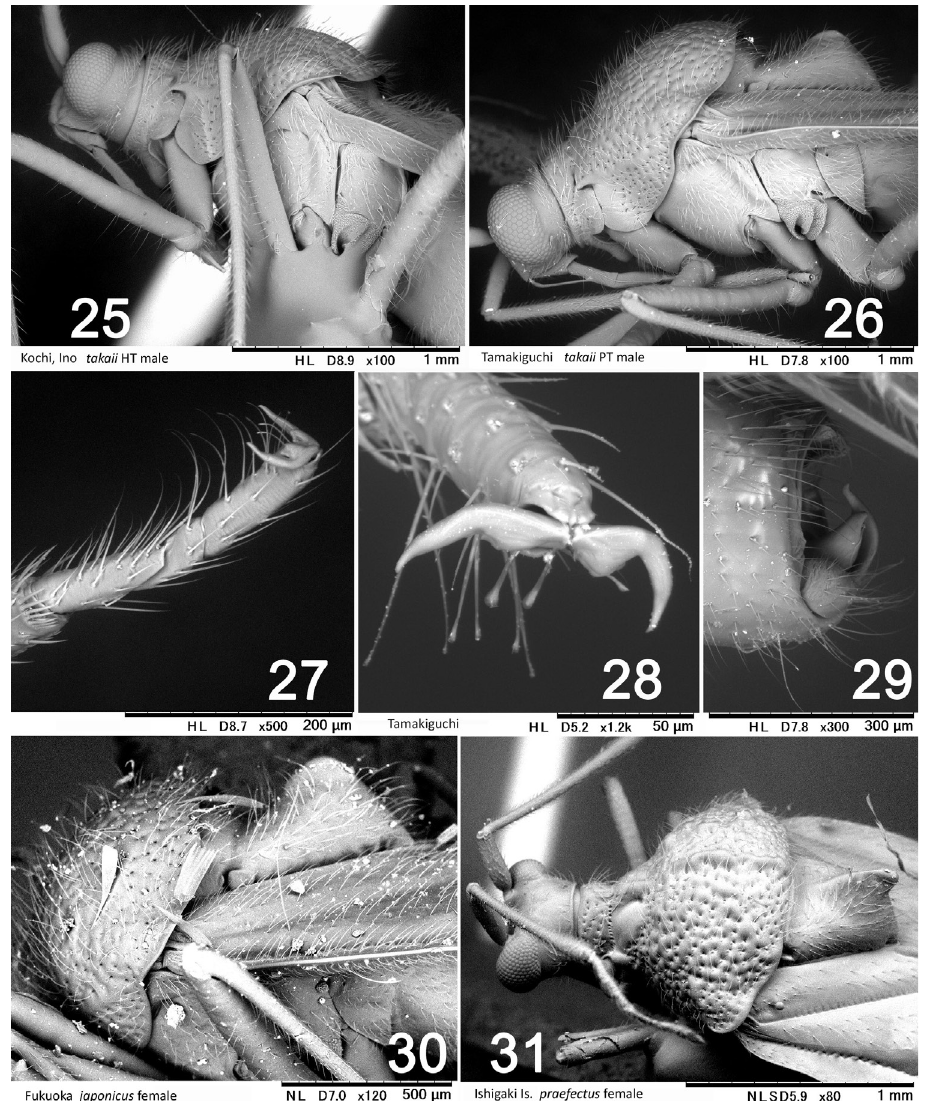
Figures 25–31. Scanning electron micrographs of Stethoconus species. 25–29 S. takaii 30 S. japonicus 31 S. praefectus 27 tarsus 28 tarsal claw 29 terminal abdomen. Diagnosis. Coloration generally dark; antennal segment II, or at least basal and api- cal 1/3, darkened; areas between pronotal punctures rather smooth; scutellum weakly elevated and blackish; mesepimeron blackish; abdomen mostly blackish. Description. Body generally maculate; dorsum shiny, densely clothed with long erect yellowish setae. Head shiny yellowish brown; brown stripe on vertex. Antenna dark brown; basal 1/3 or half of segment I somewhat pale, sometimes tinged with